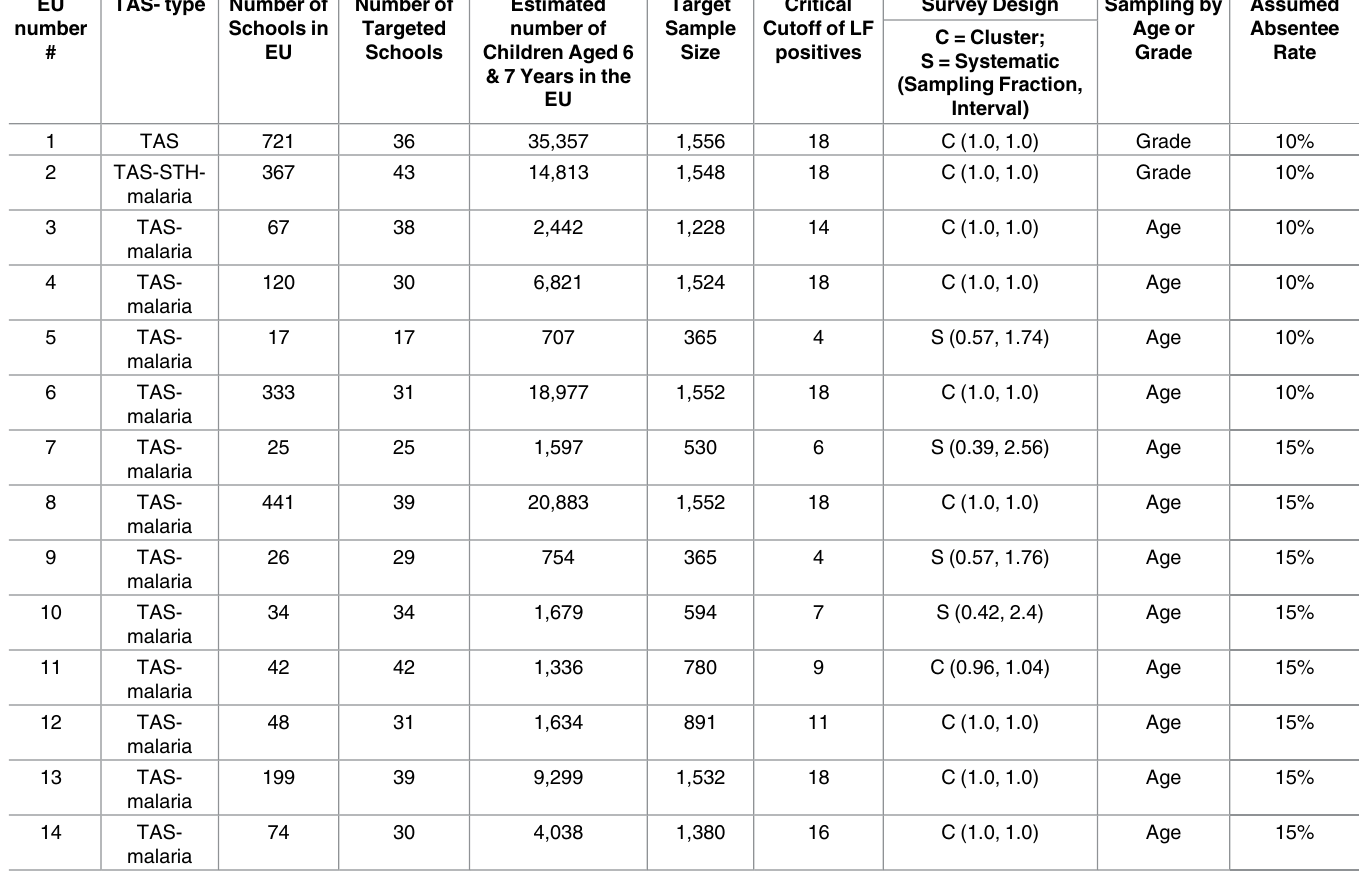
Table 2. Transmission Assessment Survey Design by Evaluation